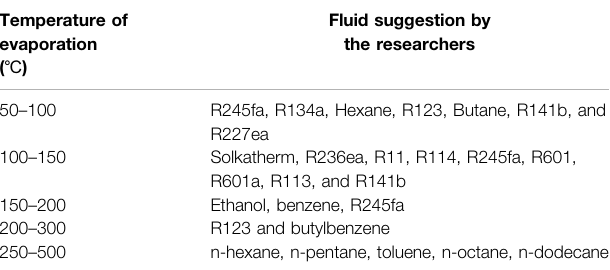
TABLE2| Selectionoftheworking fl uidforORCsbasedontheliterature(Baoand Zhao, 2013; Thurairaja et al., 2019). Temperature of